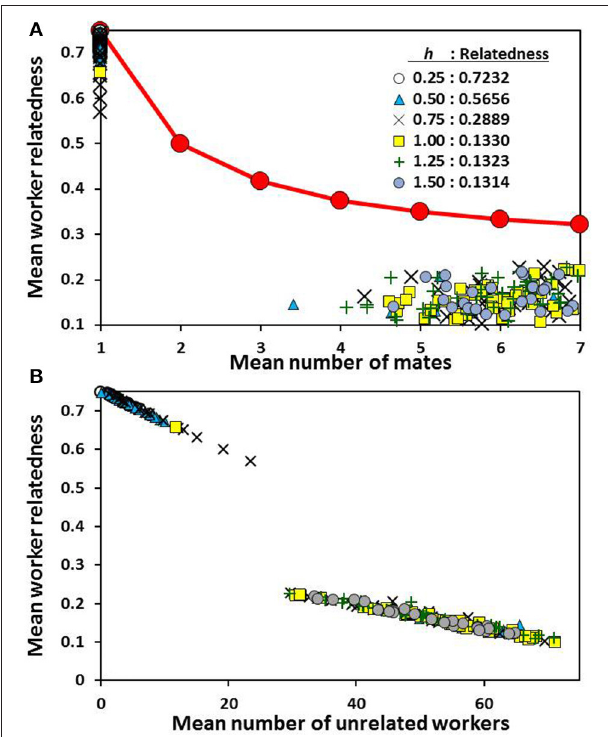
FIGURE 3 | Mean within-group relatedness of workers as a function of the mean number of mates (A) and the number of unrelated workers averaged across all colonies (B) . Every point is for a single simulation run at a given level of relative strength of social heterosis expression ( h ). The red line is the expected relatedness between workers based on the number queen mates. The observed relatednesses, averaged across simulations for a given h value, are given in the